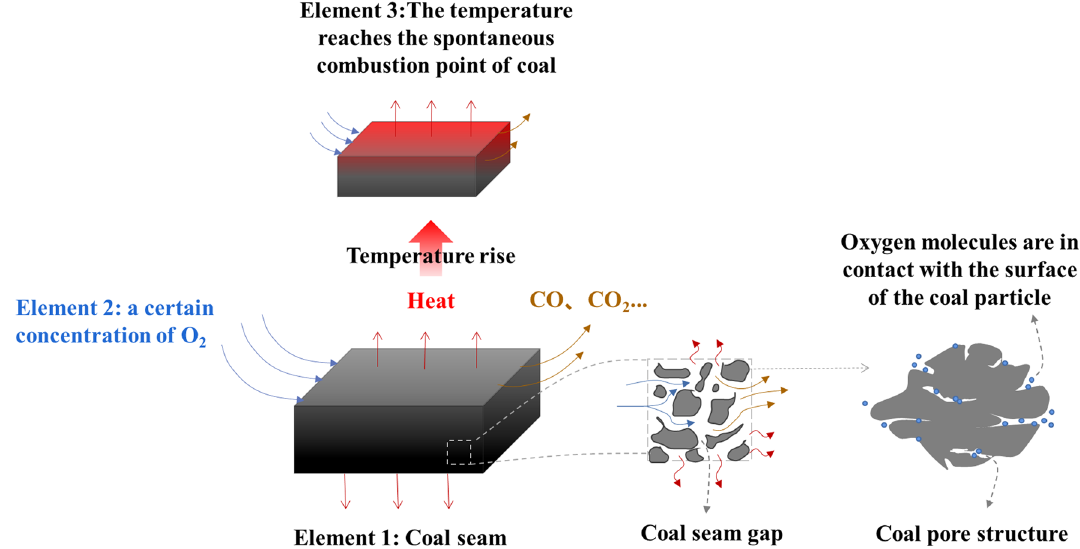
Fig. 5 Diagram of the three elements for the occurrence of underground coal